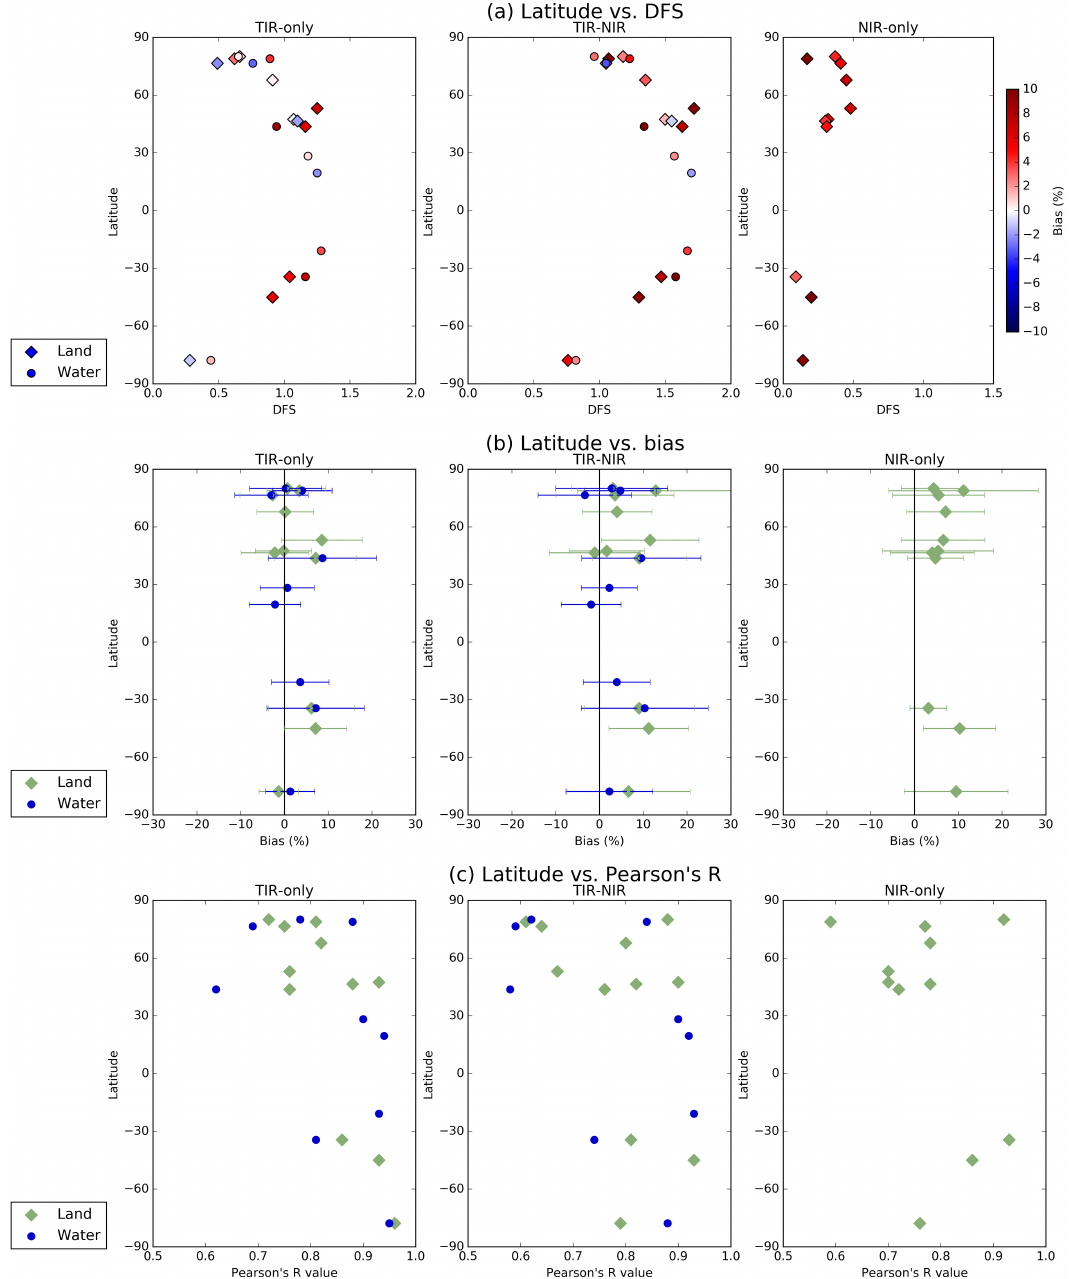
Figure 6. Latitudinal relationship with DFS (a) , relative bias ((MOPITT–FTS)/FTS, b ), and Pearson’s R correlation value (c) . Error bars in bias plots denote standard deviations. Columns are for the different MOPITT data products – column 1: TIR-only, column 2: TIR–NIR, and column 3: